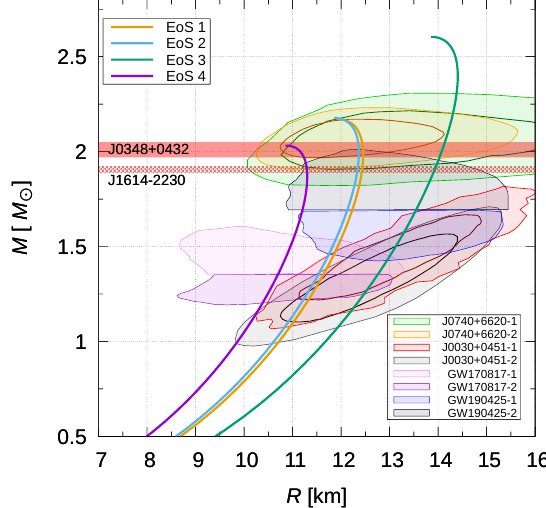
Figure 5. Mass–radius relationships for the sets of Table 2. Continuous curves represent low-MF QSs, and dotted curves represent magnetars. Due to the insignificant effects of the MF on the QS structure, the two scenarios are indistinguishable (see the enlarged details in Figure 6). We also present astrophysical constraints from the ∼ 2 M (cid:12) pulsars [16,18], the GW170817 [21] and GW190425 [22] events, and NICER observations